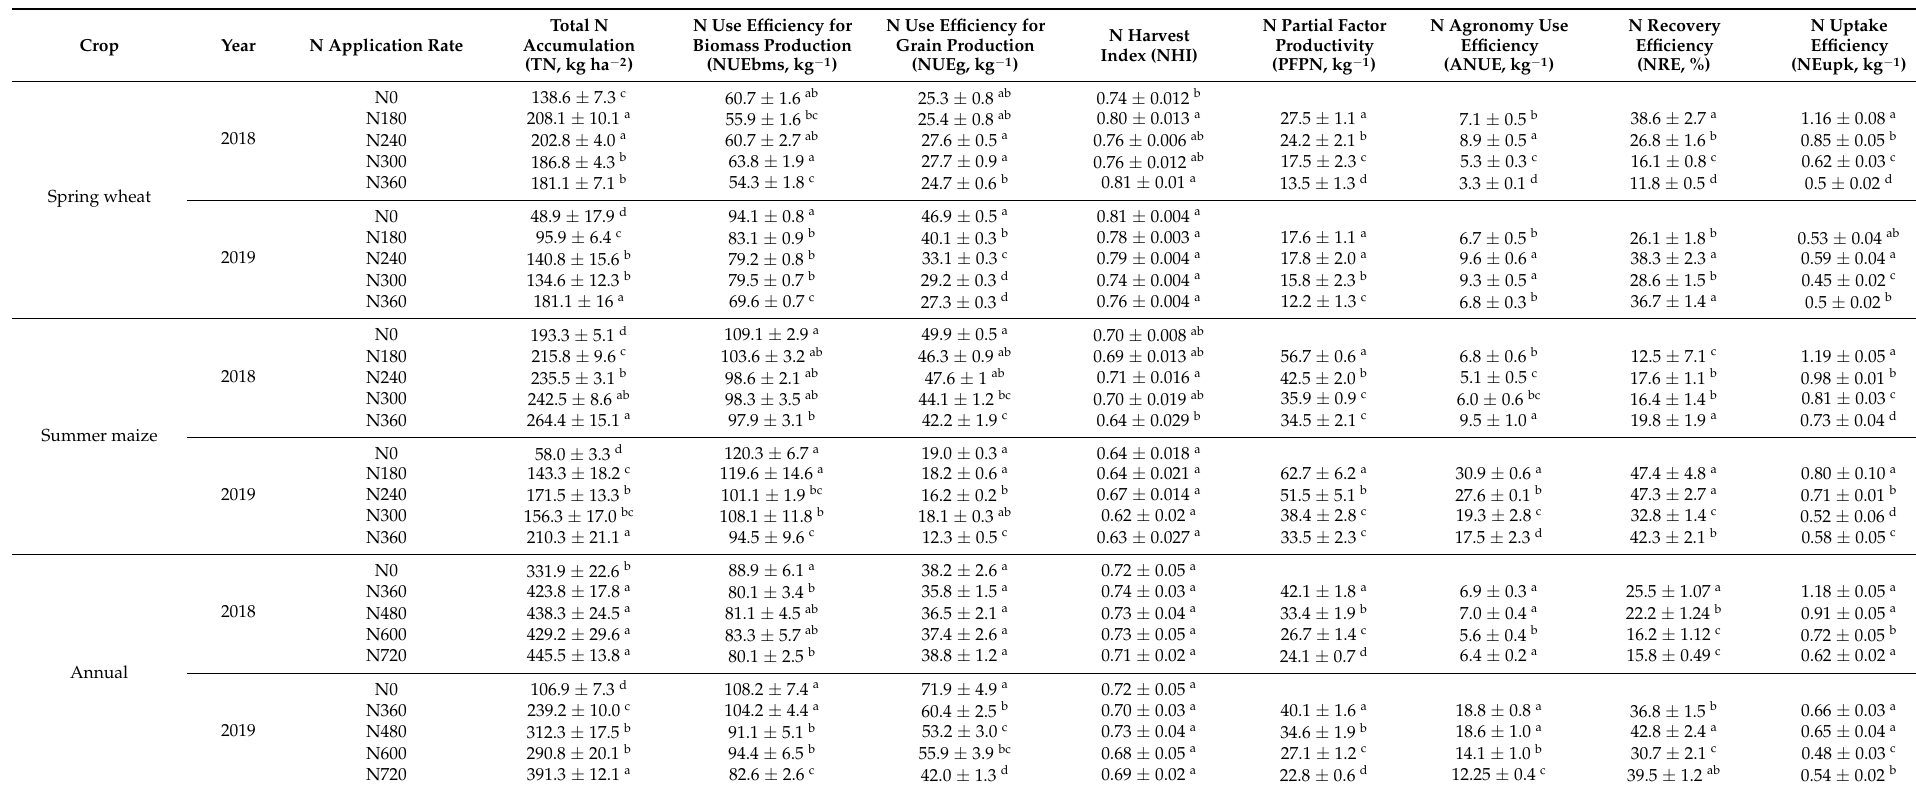
Table 3. Spring wheat, summer maize and annual cereal nitrogen accumulation and utilization response to different nitrogen application